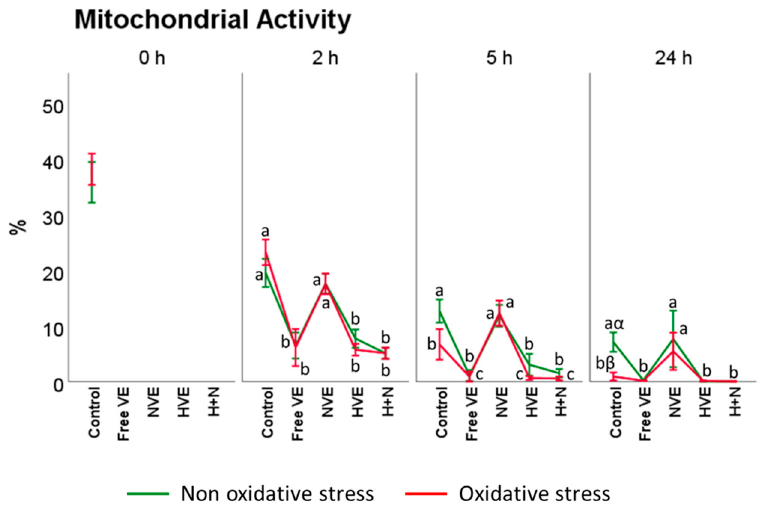
Figure 8. Vitamin E formulation effects on mitochondrial activity. Plots represent the triple interac- tion of different vitamin E treatments × oxidative treatment × incubation time for the flow cytometry analysis of mitochondrial activity (YOPRO1 − /Mitotracker deep red+). The various lowercase Latin letters ( p < 0.05) indicate significant differences between vitamin E treatments, while the different Greek letters ( p < 0.05) compare each treatment at the same time with a different oxidative stress status.